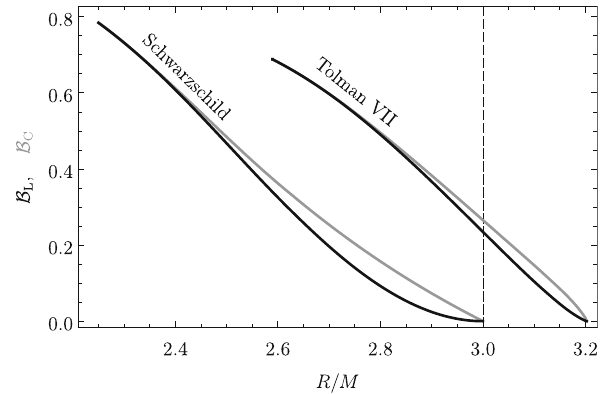
Fig. 9 The dependence of luminosity global trapping efficiency coef- ficient B L (black) and cooling global trapping coefficient B C (grey) for Schwarzschild and Tolman VII